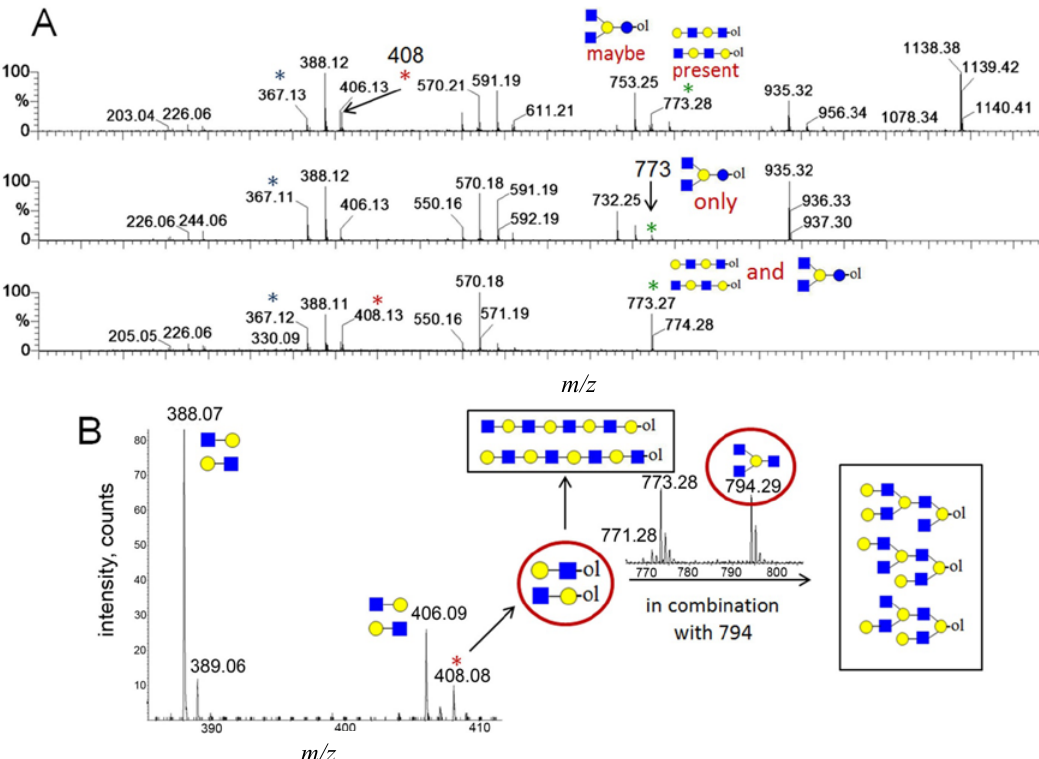
Figure 3. The assignment of CID MS data using diagnostic (367 and 794) and conditional diagnostic (408 and 773) fragment ions. ( A ) Ions at m / z = 773, 935 and 1138; and ( B ) zoom-in of the mass range of 385–410 and 770–800 Da. Possible structures are all in accord with the fragmentation pattern. denotes N -acetylglucosamine, galactose and glucose. *, * and * denote ions relevant to the explanation in the text.